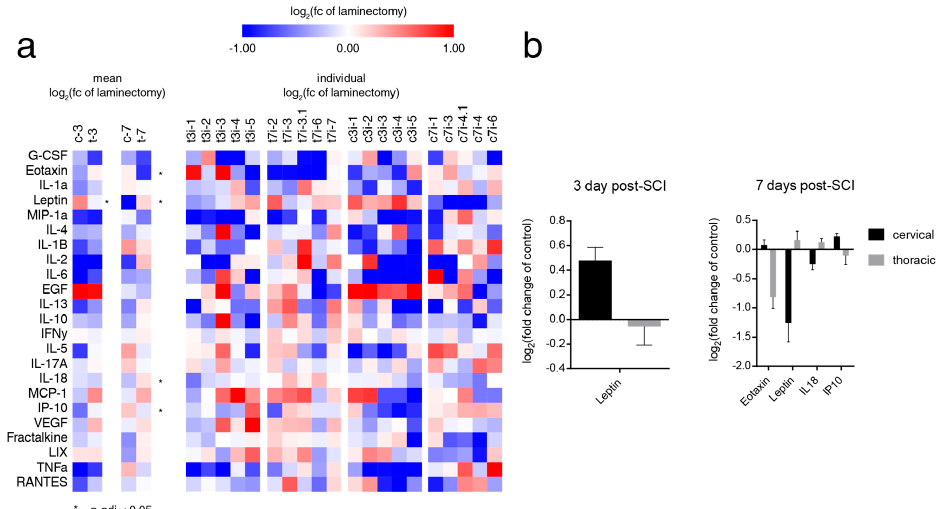
Figure 4. SCI induces changes in the splenic expression of cytokine/chemokines in a level-dependent and time-dependent manner. ( a ) Heatmap demonstrating both the individual and the mean log 2 fold change of control after cSCI and tSCI. At 3-days post-injury, tSCI had relatively lower levels of leptin compared to cSCI (Kruskal–Wallis, * p = 0.028, t = 4.811, DF = 1, n = 5/group, all pairwise comparisons). At 7-days post-injury, tSCI had relatively lower levels of eotaxin (Kruskal–Wallis, * p = 0.028, t = 4.840, DF = 1, n = 5/group, all pairwise comparisons) and IP10 (Kruskal–Wallis, * p = 0.047, t = 3.938, DF = 1, n = 5/group, all pairwise comparisons) compared to cSCI. Contrastingly, tSCI had relatively elevated levels of leptin (Kruskal–Wallis, * p = 0.009, t = 6.818, DF = 1, n = 5/group, all pairwise comparisons) and IL18 (Kruskal–Wallis, * p = 0.016, t = 5.771, DF = 1, n = 5/group, all pairwise comparisons). ( b ) Bar graphs showing only the cytokines/chemokines that were significantly different between the levels at 3- and 7-days post-injury. Data shown as mean fold change of time-matched control ± SEM ( n = 3/control group).